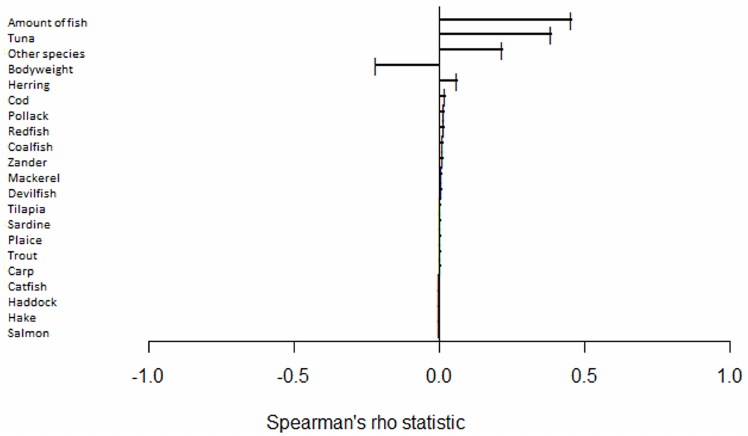
Fig 2. Tornado chart of the major influencing factors. Illustrating Spearman 0 s rank correlation coefficients of the major influencing factors and the maternal hair concentration of methylmercury.